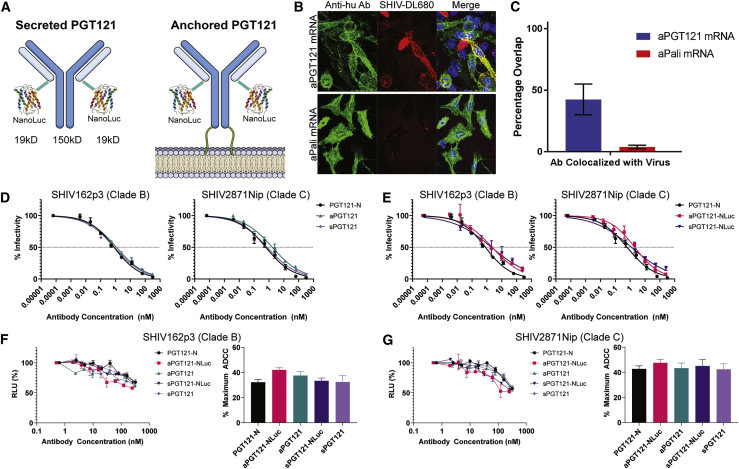
Transfected Cells Displaying Membrane-Anchored PGT121 on Their Surface Bind SHIV Virions(A) Schematic of the PGT121-NanoLuc fusion protein, in secreted and anchored forms. NanoLuc was fused to the 3′ end of the kappa light chains (2 per antibody molecule). In the case of the membrane-anchored PGT121, a GPI anchor was fused to the 3′ end of the HC. Total MW of anchored PGT121-NanoLuc was 195 kDa (B) HEK293 cells were transfected with 1 μg of PGT121 mRNA, delivered at a 4:1 ratio of HC to LC with Lipofectamine 2000 (top row). Respiratory syncytial virus neutralizing anchored Palivizumab (aPali) antibody mRNA was used as a control comparison (bottom row). 24 h later, DyLight 680-labeled SHIV particles (red) were incubated with the transfected cells for 4 h without agitation. After washing 3×, the cells were fixed and immunostained with an anti-human secondary antibody (green). (C) Average percentage overlap between SHIV virus and anchored antibodies from panel (B), using 30 cells per condition. The error bars represent the mean ± 95% CI. (D) Anchored and secreted PGT121 was produced in Vero cells and purified. The mRNA-expressed antibodies were compared against parental PGT121 for SHIV neutralization with either a clade B or clade C SHIV isolate. Error bars represent SD. (E) Anchored and secreted PGT121 fused to NanoLuc was produced in Vero cells and purified. The mRNA-expressed NanoLuc fusion antibodies were compared against parental PGT121 for SHIV neutralization with either a clade B or clade C SHIV isolate. Error bars represent SD. (F) mRNA-expressed anchored or secreted PGT121 either with or without NanoLuc was purified, diluted, and tested for ADCC against SHIV162p3 (clade B). Complete dilution series (left) and percent maximal ADCC (right) are shown. Error bars represent SD. Percent maximum ADCC compared by Kruskal-Wallis. (G) The same antibodies from (F) were purified, diluted, and tested for ADCC against SHIV2871Nip (clade C). Complete dilution series (left) and percent maximal ADCC (right) are shown. Error bars represent SD. Percent maximum ADCC compared by Kruskal-Wallis.